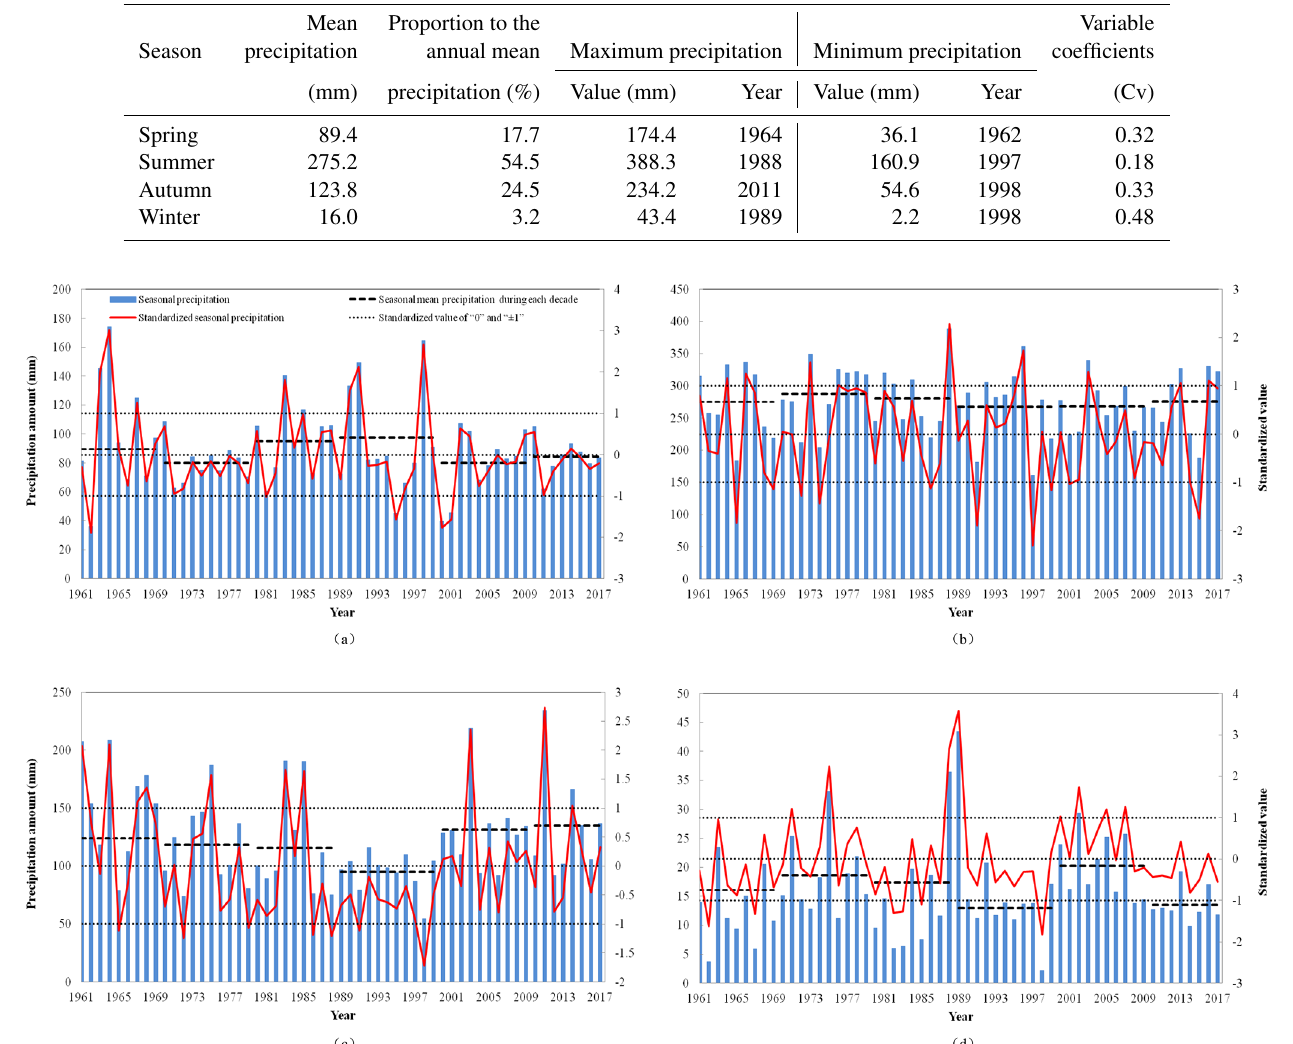
Table 1. Seasonal precipitation eigenvalues in the Yellow River Basin.